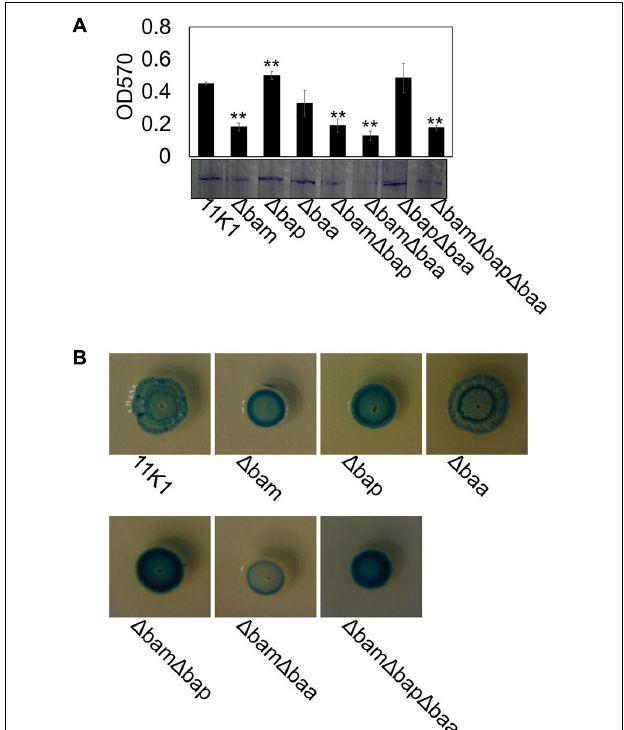
FIGURE 6 | Effects of CLP gene mutations on bacterial biofilm formation (A) and colony morphology (B) . (A) Spectrophotometric quantification of biofilms formed by Pseudomonas sp. 11K1 and CLP mutants. Mean values of three replicates are given, and error bars indicate standard error. Visual representation of biofilm formation by Pseudomonas sp. 11K1 and CLP mutants on tubes is shown. Biofilms were stained with Crystal Violet. (B) Colony morphology detected on PDA plates. A 5 µ L sample of overnight culture of WT 11K1 or mutant strains was spot-inoculated in the center of a PDA plate and incubated for 48 h at 28 ◦ C. (cid:49) bam, brasmycin gene cluster deletion mutant; (cid:49) bap, braspeptin gene cluster deletion mutant; (cid:49) baa, brasamide gene cluster deletion mutant; (cid:49) bam (cid:49) bap, brasmycin and braspeptin double gene cluster deletion mutant; (cid:49) bam (cid:49) baa, brasmycin and brasamide double gene cluster deletion mutant; (cid:49) bap (cid:49) baa, braspeptin and brasamide double gene cluster deletion mutant; (cid:49) bam (cid:49) bap (cid:49) baa, brasmycin, braspeptin, and brasamide triple gene cluster deletion